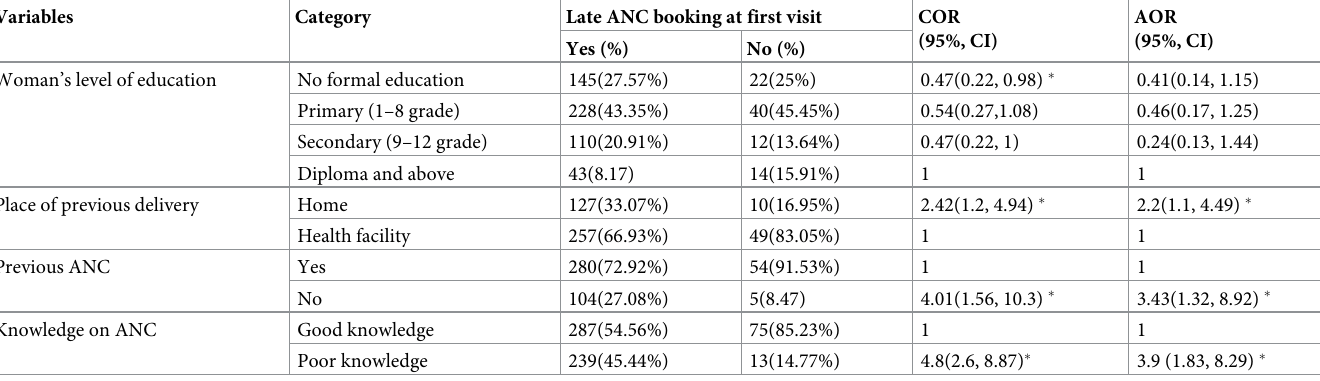
Table 3. Bivariable and multivariable analysis on factors associated with late ANC booking at first visit.